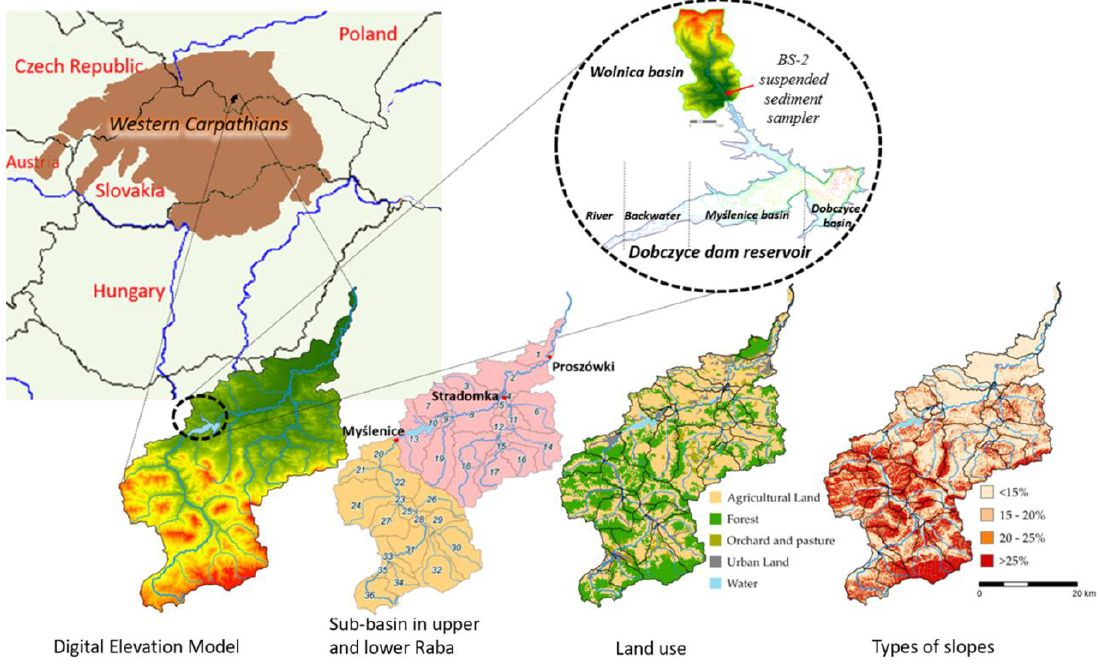
Figure 2. The Raba River basin with topography (DEM), division into sub-basins (calibration and validation points), land use, slopes, and the approximate area of the Wolnica basin with the Dobczyce dam reservoir.